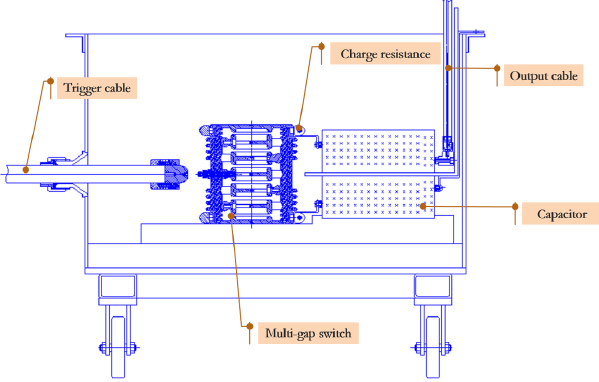
FIG. 15. Configuration of the latter-trigger unit.